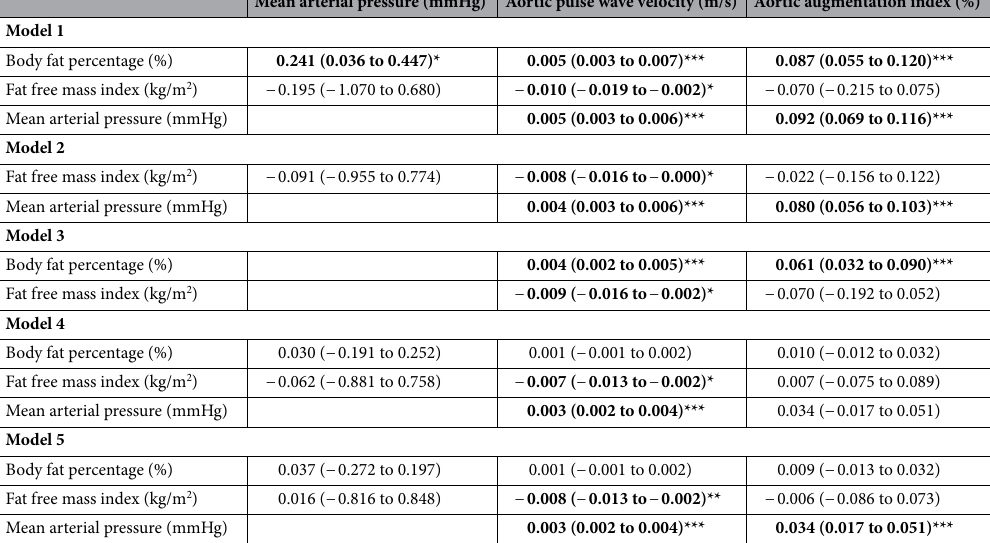
Table 3. Associations of body composition and mean arterial pressure with arterial stiffness in women. The data are β coefficients and their 95% confidence intervals. Model 1: unadjusted, Model 2: the data were adjusted for model 1 + body fat percentage, Model 3: the data were adjusted for model 1 + mean arterial pressure, Model 4: the data were adjusted for model 1 + age, Model 5: the data were adjusted for body fat percentage, fat-free mass index, mean arterial pressure, age, and V ̇ O 2peak (mL/kg FFM/min). Aortic pulse wave velocity was logarithmically transformed, and square root transformation was applied to Aortic augmentation index *p < 0.05, **p < 0.01, ***p < 0.001. Significant associations are in